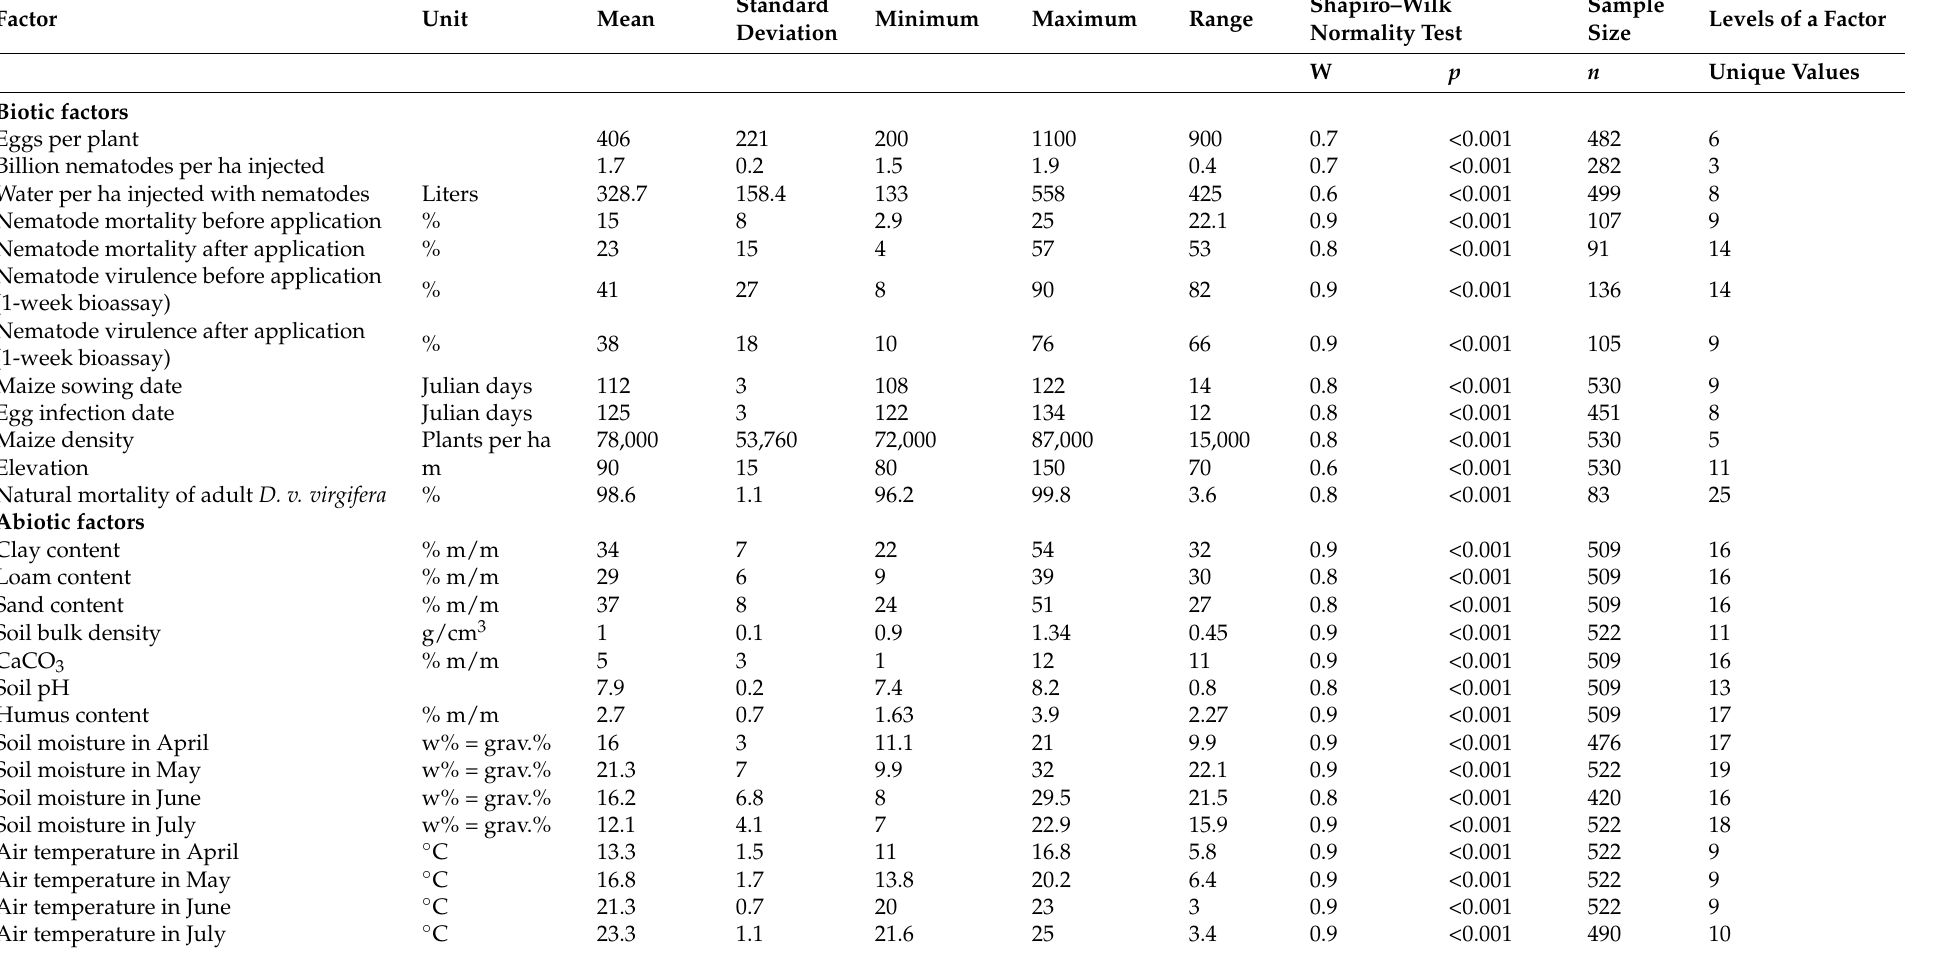
Table 1. Characteristics of abiotic and biotic factors analyzed for their influence on the efficacy of soil insecticides and entomopathogenic nematodes in